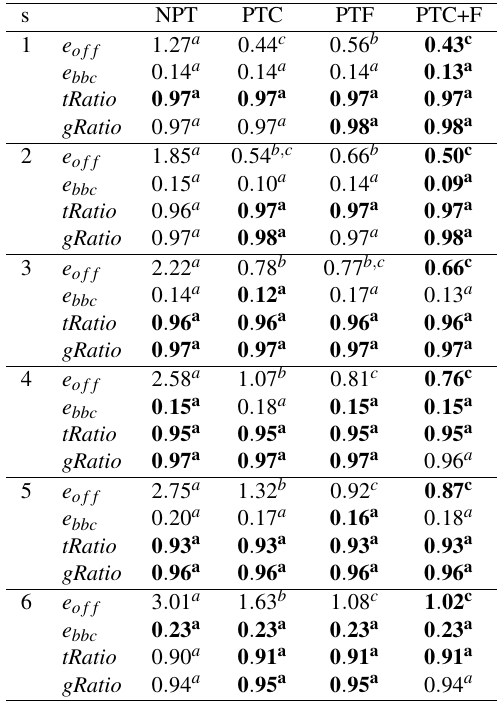
Table 4. e of f , e bbc , tRatio and gRatio obtained by NPT, PTC, PTF and PTC+F over six MPB configurations with different shift severities ( s = 1 ,..., 6). The superscripts of the values pro- vide the same information explained in Table 3.